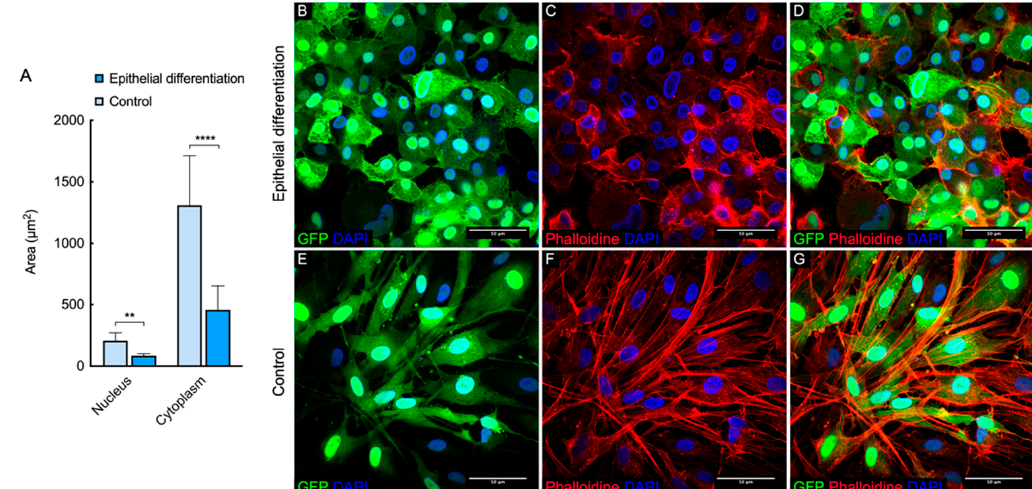
Figure 5. Confocal images of the actin cytoskeleton of L-MSCs-EGFP stained with DAPI Phalloidin-TRIC after induction in epithelial medium ( A – C ) and control L-MSCs-EGFP ( D – F ). ( A , D ) DAPI and GFP channels. ( B , E ) DAPI and TRITC channel. ( C , F ) Merge of three channels (DAPI, GFP, TRITC). The scale bar on all images 50 micrometers ( µ m). ( G ) The plot illustrates the change in the size of cells and nuclei during epithelial differentiation. Data represented as average ± S.D. from three independent experiments ( n = 3; ** and **** corresponds to p < 0.001 and 0.0001 after two-way ANOVA, respectively).